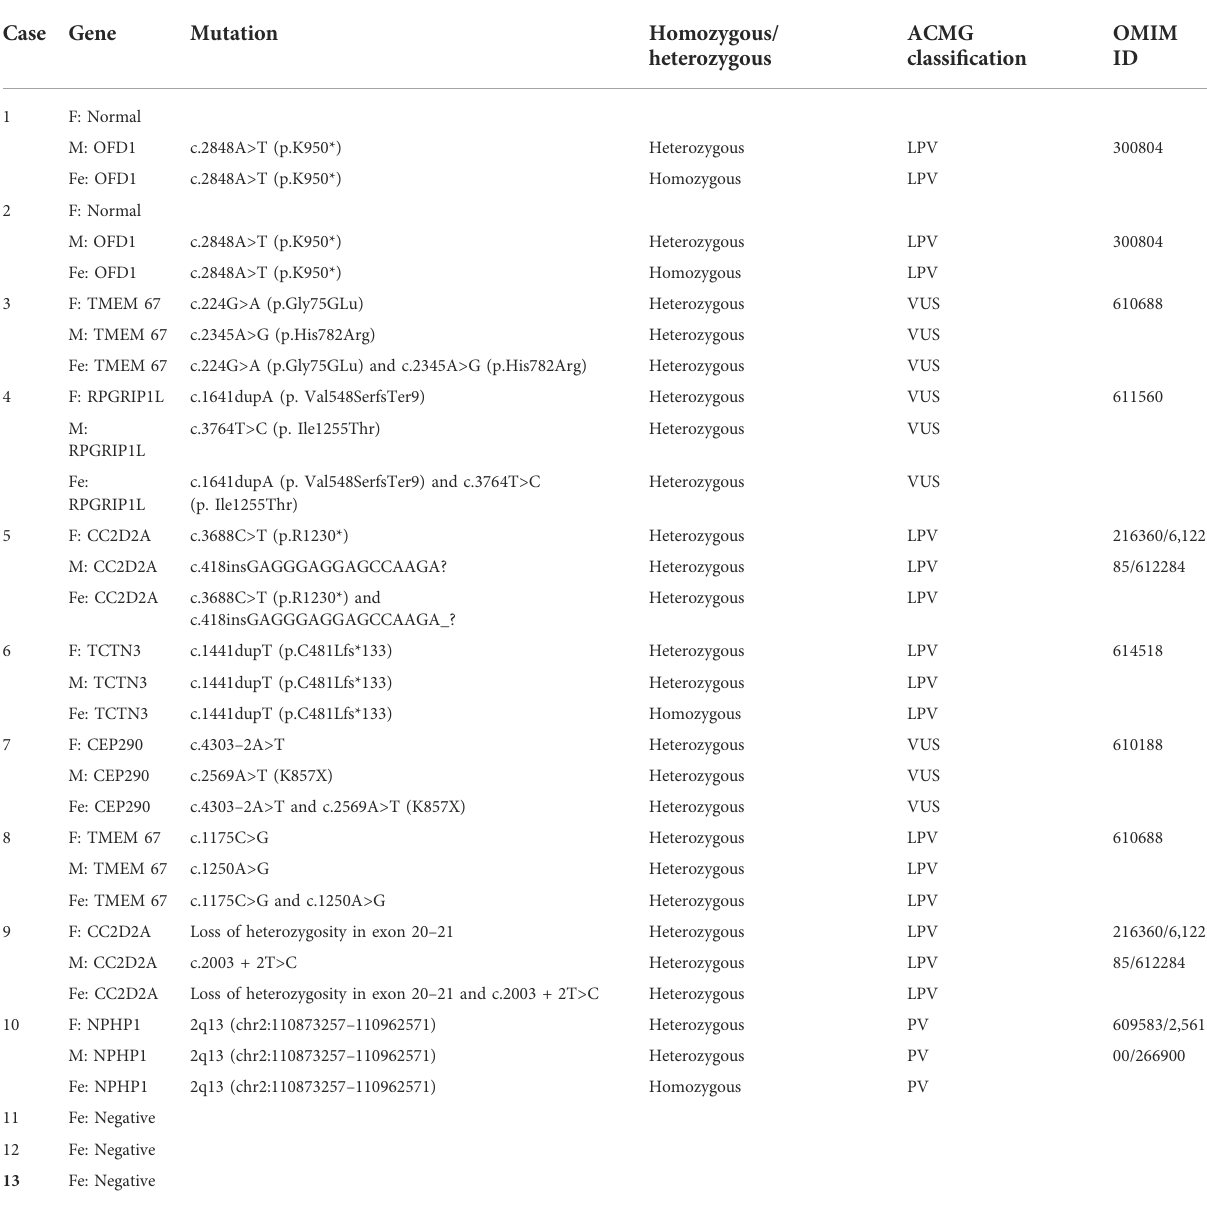
TABLE 2 Results of 13 cases in